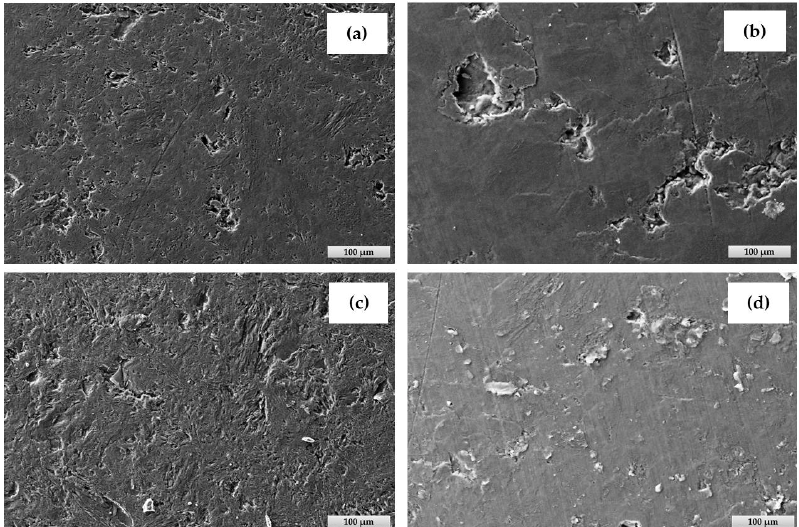
Figure 5. Scanning electron microscopy (SEM) images of pre-activated BPPs in ( a ) set-up A and ( b ) set-up B, and BPPs after electrochemical aging in ( c ) set-up A and ( d ) set-up B.